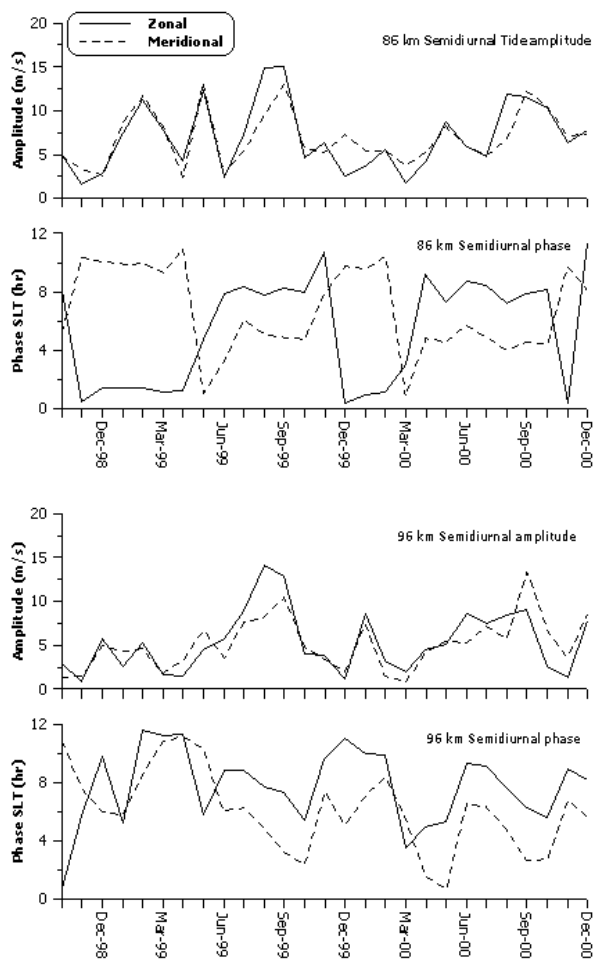
Fig. 10. Semidiurnal tidal amplitude and phase observed at Poker Flat for the heights 86 and